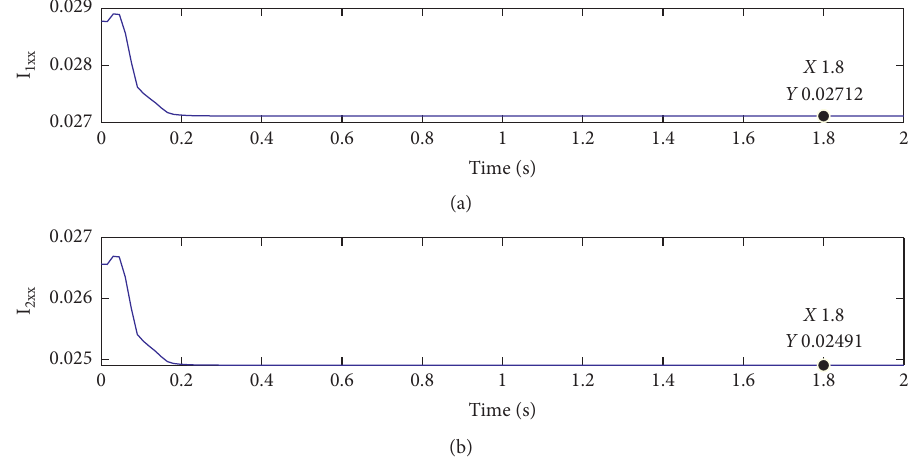
Figure 18: The moment of inertia of I